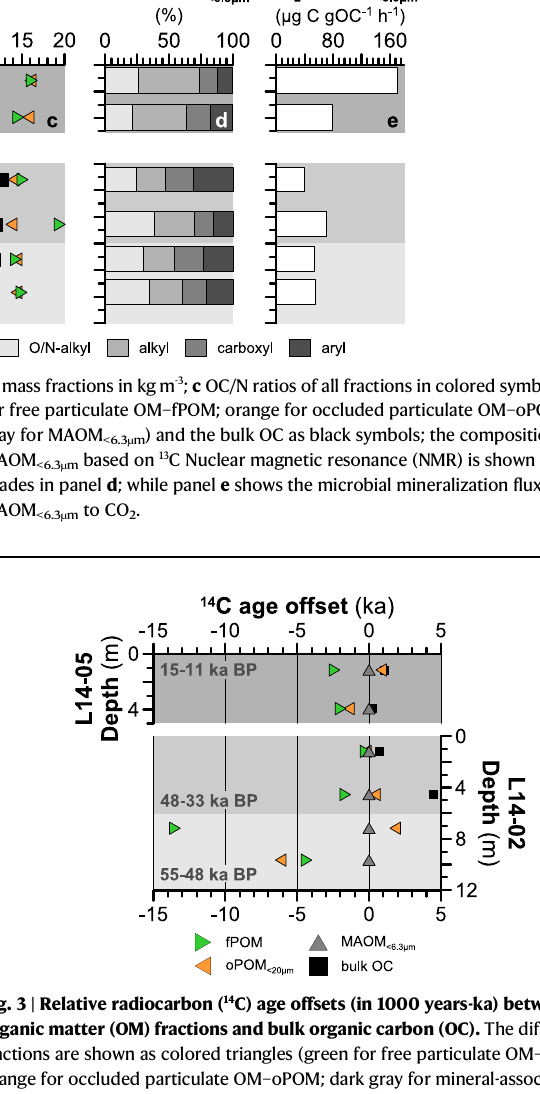
Fig. 3 | Relative radiocarbon ( 14 C) age offsets (in 1000 years-ka) between organic matter (OM) fractions and bulk organic carbon (OC). The different OM fractions are shown as colored triangles (green for free particulate OM – fPOM; orange for occluded particulate OM – oPOM; dark gray for mineral-associated OM- MAOM <6.3 µ m ) and bulk OC is shown as fi lled black square symbol. All results are normalized to the ages of the MAOM <6.3 µ m fraction. The bulk OC of the two deep samples in L14-02 revealed in fi nite 14 C ages and were excluded from this fi